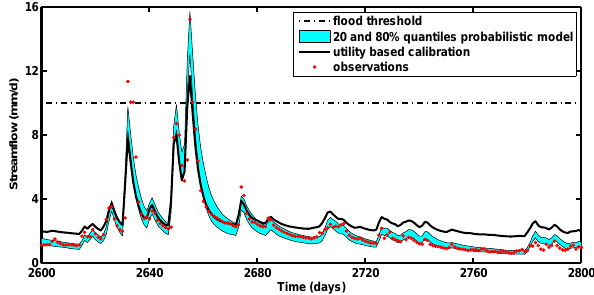
Fig.4. Theresultsfrombothmodels,comparedwithobservations.Fortheprobabilisticmodel,the20%and80%quantilesareshown.With thecost-lossratioof0.2usedinthisexample,theupperquantiledeterminesthedecision. Fig. 4. The results from both models, compared with observations. For the probabilistic model, the 20% and 80% quantiles are shown. With the cost-loss ratio of 0.2 used in this example, the upper quan- tile determines the